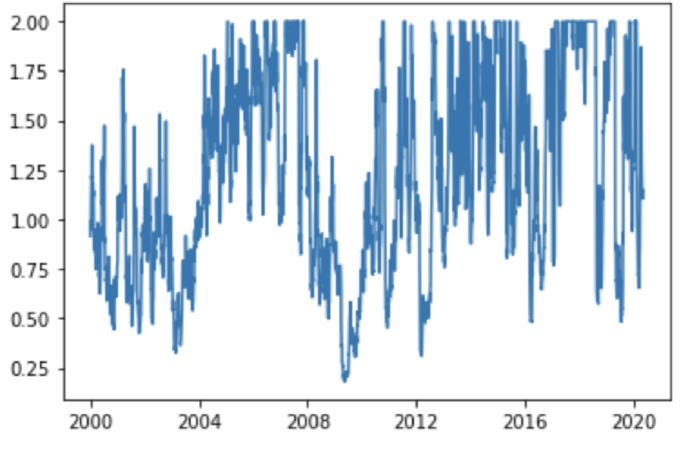
Figure 12. Exposure of the risky asset described by the weights α 1 (source: authors’